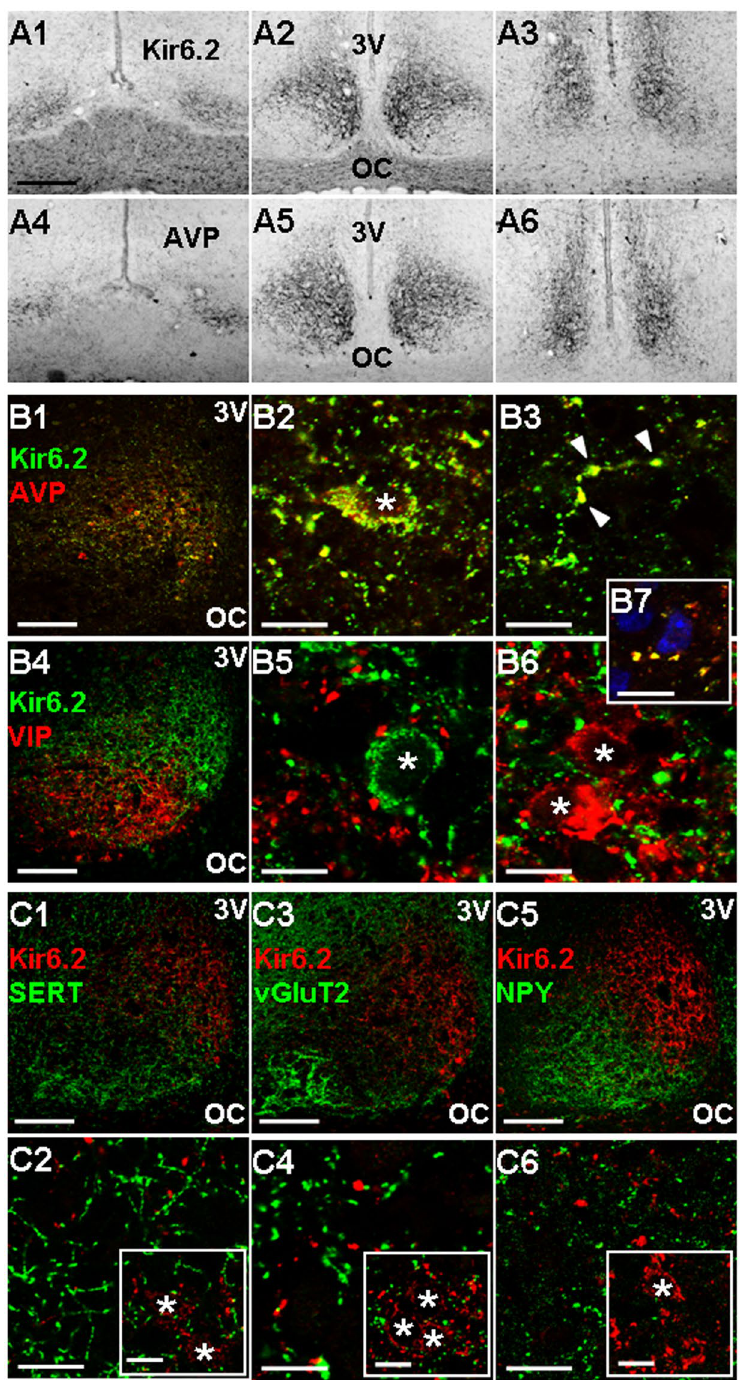
Figure 2. Distribution and localization of Kir6.2 immunoreactivity (ir) in the SCN. ( A ) Distribution of the Kir6.2 (A1–3) and AVP (A4-6) immunoreactivity in the rostral (A1, A4), middle (A2, A5), and caudal (A3, A6) sections of the SCN. Scale bar: 200 µ m. ( B ) Selective colocalization of Kir6.2-ir with AVP-ir (B1–3) but not with VIP-ir (B4–6). Note the colocalization of Kir6.2-ir and AVP-ir in and around the soma (B2) and in varicosities along the process (marked by arrowheads, B3). Note the reciprocal apposition of VIP-ir bouton-like swellings against a Kir6.2-ir soma (B5) and Kir6.2-ir bouton-like swellings against VIP-ir somata (B6). Note also bouton-like swellings (yellow) double-stained with Kir6.2 (green) and AVP (red) apposing Hoechst-stained cells (blue) in the ventrolateral region of the SCN (B7). Scale bar: 100 µ m (B1, B4); 10 µ m (B2, B3, B5–7). ( C ) Lack of colocalization of Kir6.2-ir with markers for three afferent inputs SERT-ir (C1, C2), vGluT2-ir (C3, C4), NPY-ir (C5, C6). Insets: co-distribution of SERT-ir, vGluT2-ir, and NPY-ir with Kir6.2-stained somata in the ventromedial region of the mid-SCN section. Scale bar: 100 µ m (C1, C3, C5); 10 µ m (C2, C4, C6, insets). OC: optic chiasm. 3 V: third ventricle. Asterisks mark Hoechst-stained